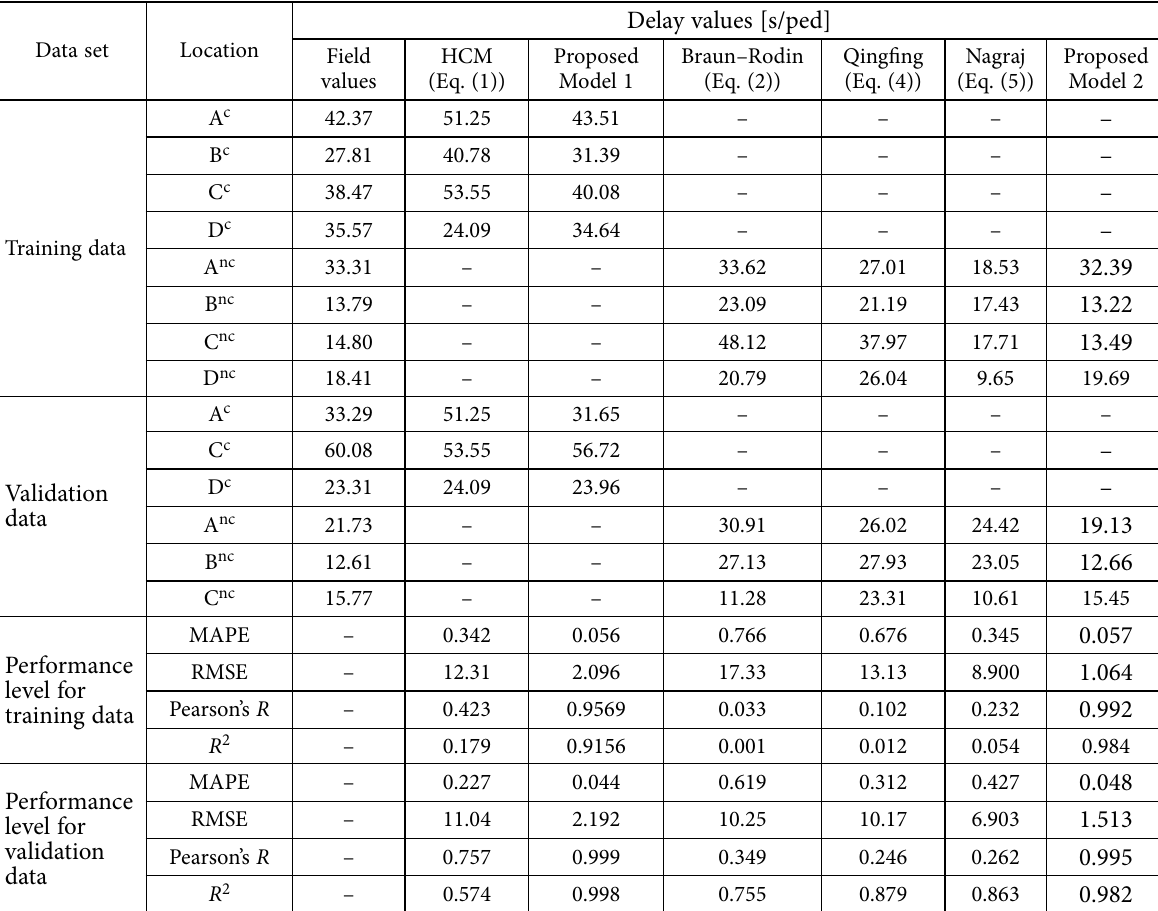
Table 5. Comparison of performance level of proposed model with existing